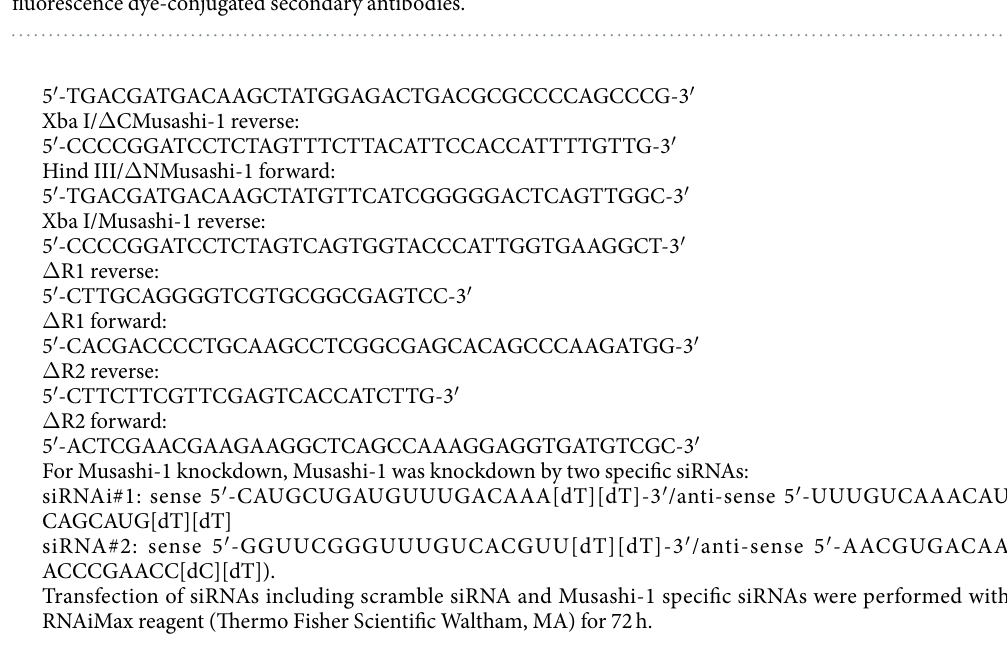
Figure 8. Increased Musashi-1 expression in CRC cells. Paired clinical samples (one stage IIA and two stage IIB samples) of normal and CRC tissues were subjected to Musashi-1 immunohistochemical staining as described in the Methods. Relative Musashi-1 expression levels were detected by a Musashi-1-specific antibody and fluorescence dye-conjugated secondary